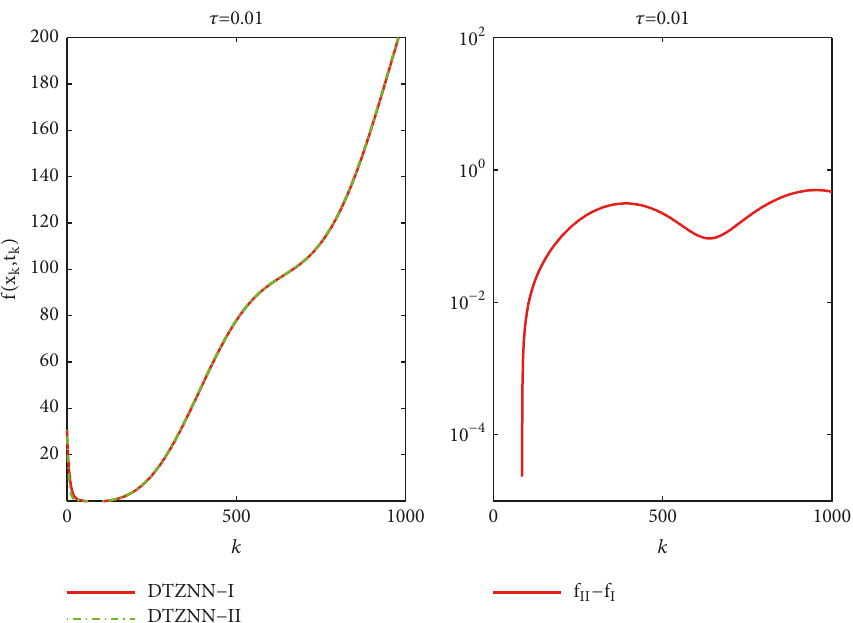
Figure 4: Trajectories of 𝑓(𝑥 𝑙 ,𝑡 𝑘 ) generated by the DTZNNs model (18) for problem